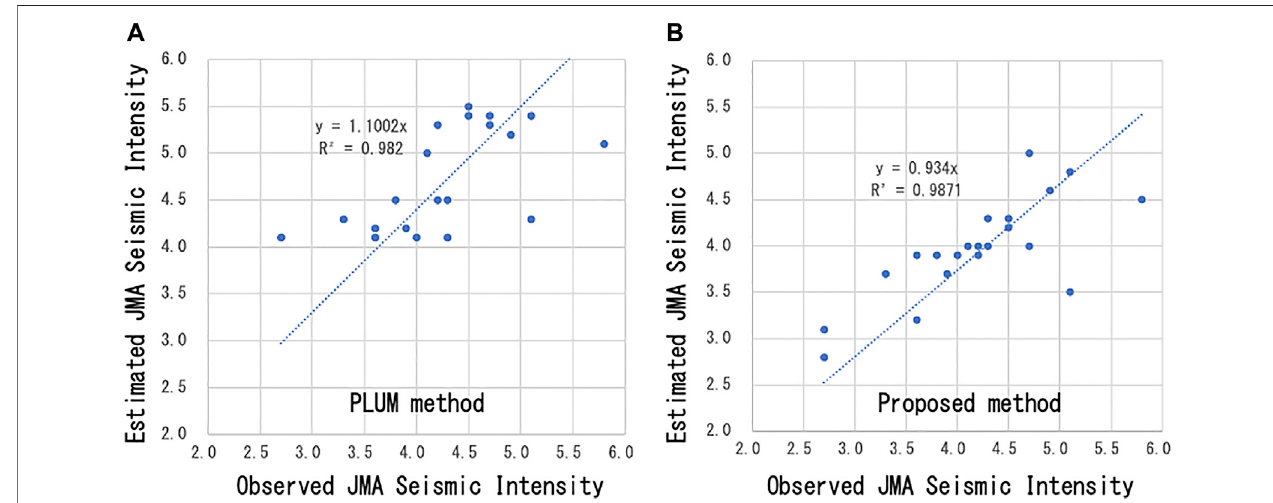
FIGURE 6 | Comparison between the observed and estimated JMA seismic intensities at the sites that are maintained by other organizations: (A) PLUM method; (B) proposed method.